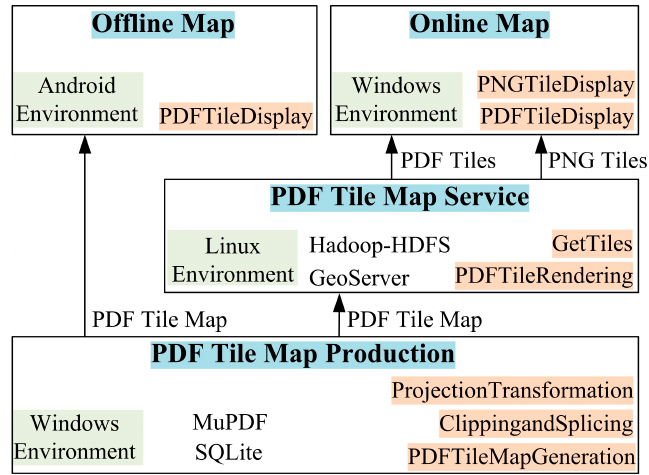
Figure 12. PDF tile map testing prototype system. PNG (portable network graphic format), HDFS (Hadoop Distributed File System). Blue background color denotes subsystem. Red background color denotes access interface. Gray background color denotes operating system.